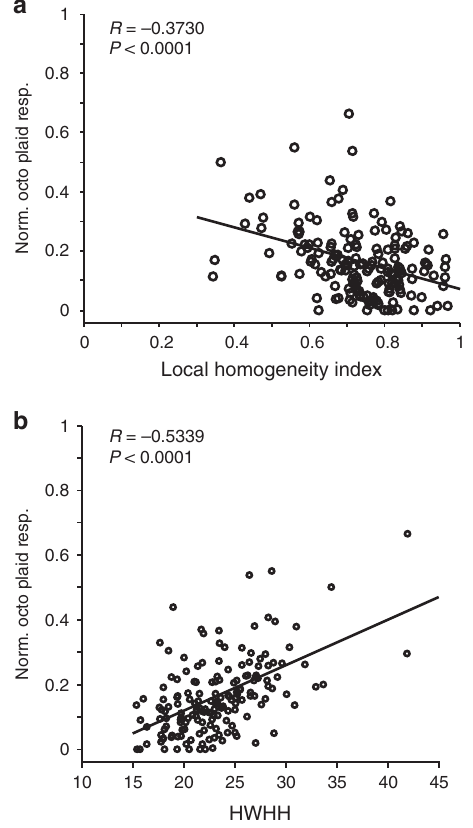
Figure 5 | Association between multiple orientation stimulus response versus local orientation topography and orientation tuning width.